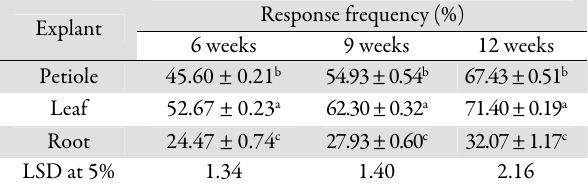
Table 5. Different explants encapsulation and their callus induction response